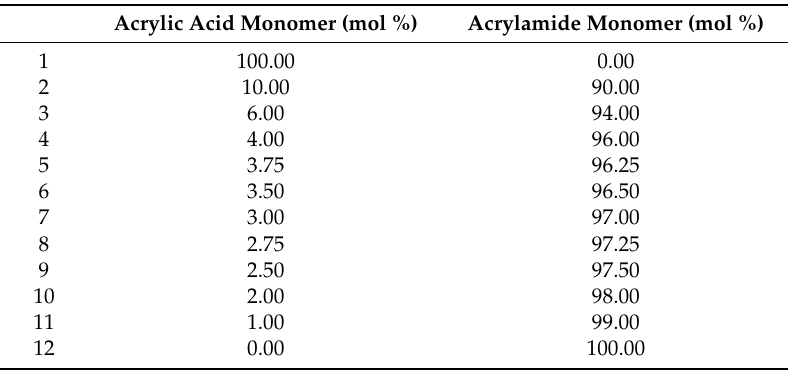
Table 1. Compositions of monomer